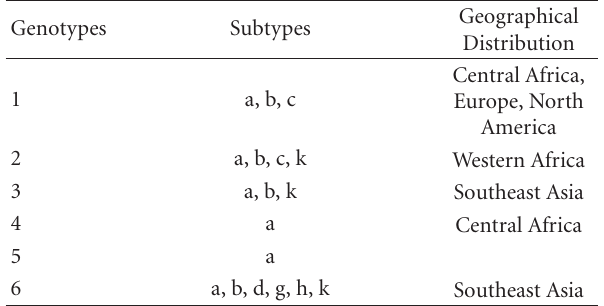
Table 1: HCV genotypes, subtypes, and their geographical distri-